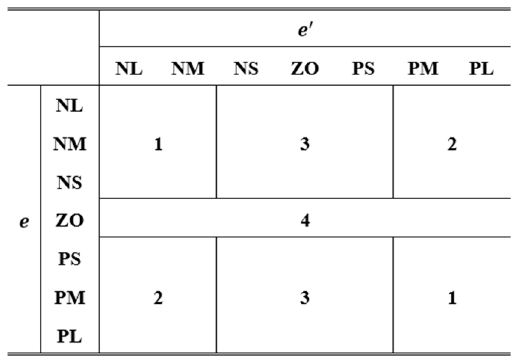
Figure 5. Partition diagram of fuzzy rules.